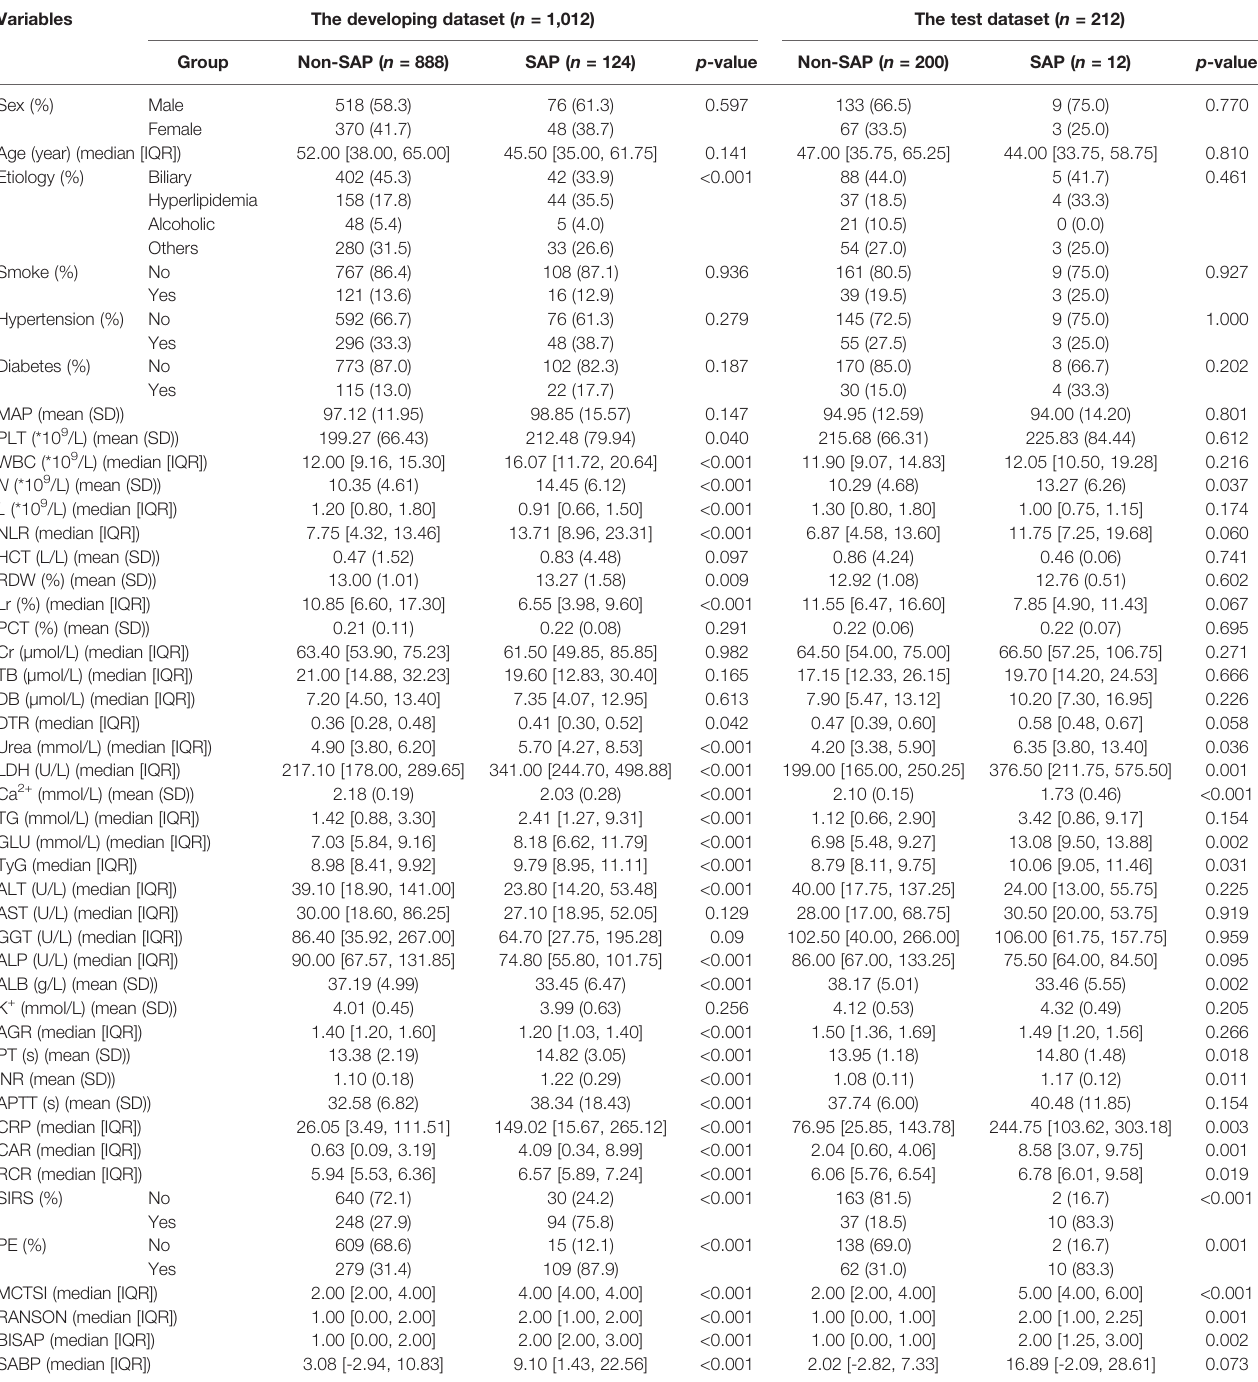
TABLE 1 | Demographic and clinical characteristics of patients in training, validation and test groups. Variables The developing dataset ( n = 1,012) The test dataset ( n =